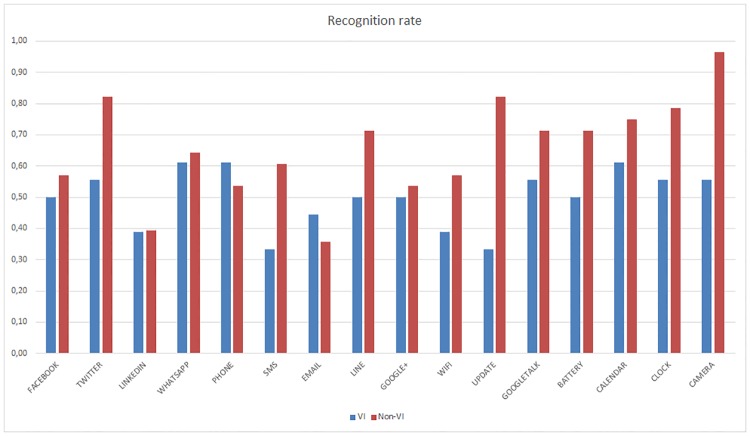
Per haptic icon recognition rate.VI vs Non-VI users for all the population.